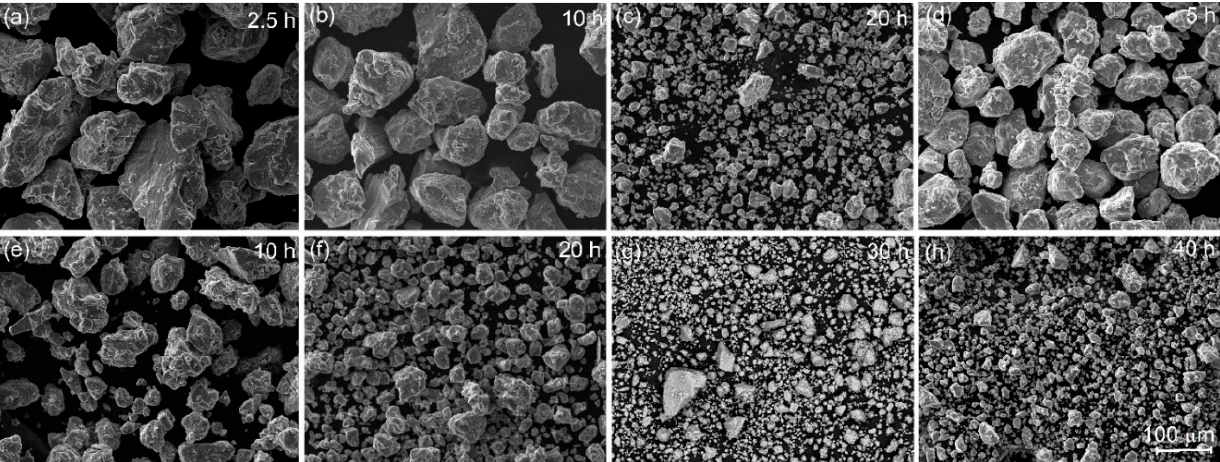
Figure 2. Morphology of the granules of ( a – c ) the mixture of the master alloy chips with Al powder (sample A) and ( d – h ) the mixture of the pre-milled master alloyed granules with Al powder (sample B), after high-energy ball milling for 2.5–40 h (micrographs presented at the same magnification).